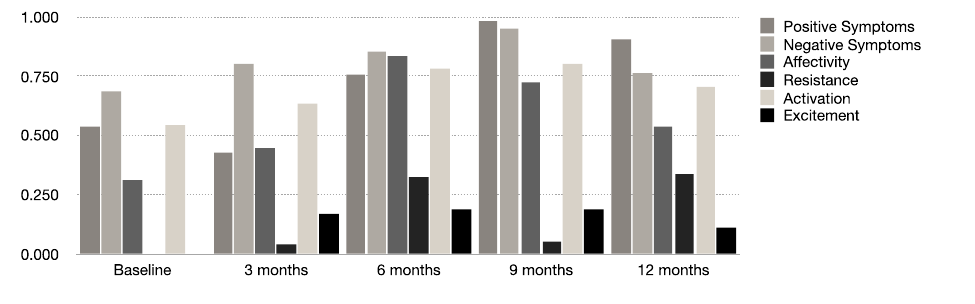
Figure 2. r 2 -values for BPRS subscales by study